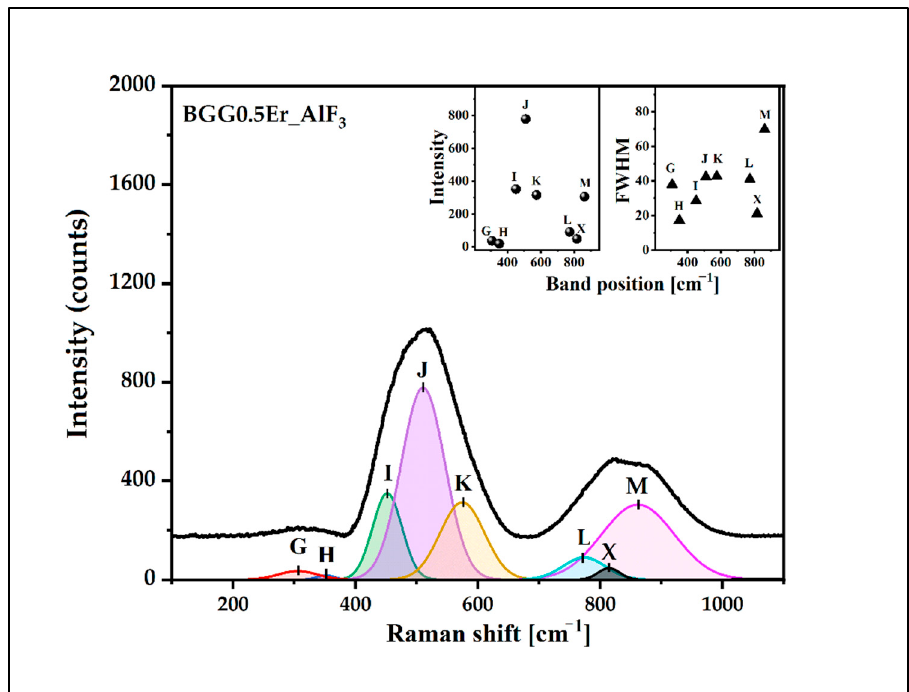
Figure 11. Deconvoluted Raman spectrum of BGG0.5Er_AlF 3 glass.